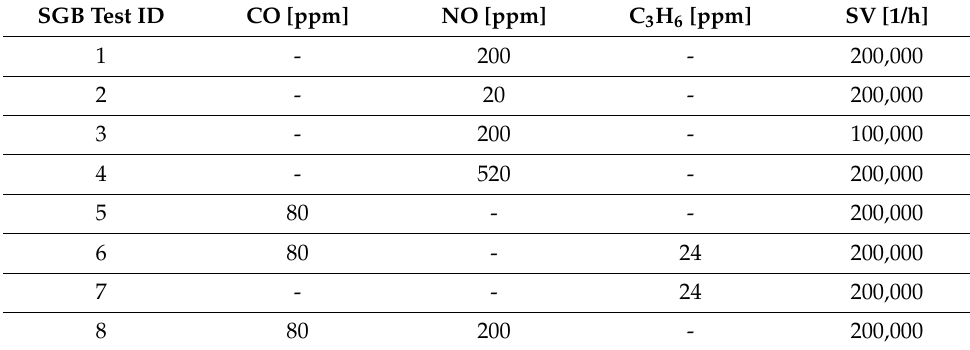
Table 7. Light off test (SGB): trace species